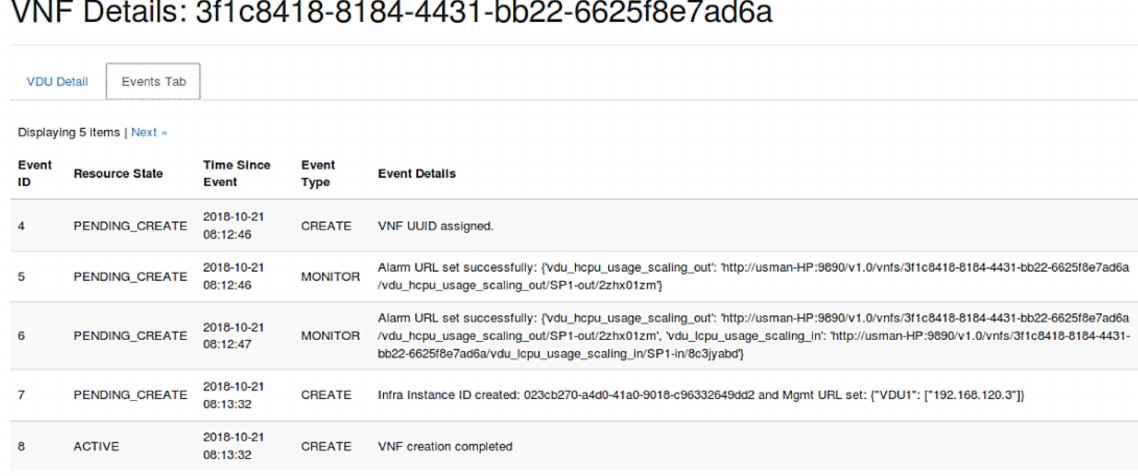
Figure 7. Creation of Virtualized Network